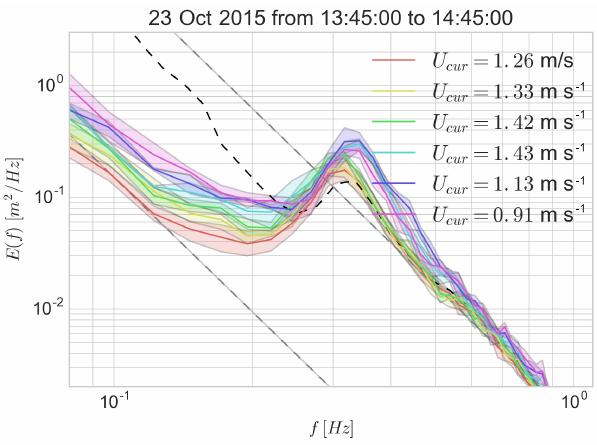
Figure 9. Saturation of the spectral density. Time evolution over 10min Fourier transform from 23 October 2015 13:40 to 14:40UTC. The colored lines follow the buoys’ displacement as in Fig. 8. The solid lines show the spatial mean of the spectral den- sity measured during each 10min acquisition. The lines’ shadow represents the 99% confidence interval. The dashed black line is the saturation measured at an offshore location by the Pierre Noires Datawell